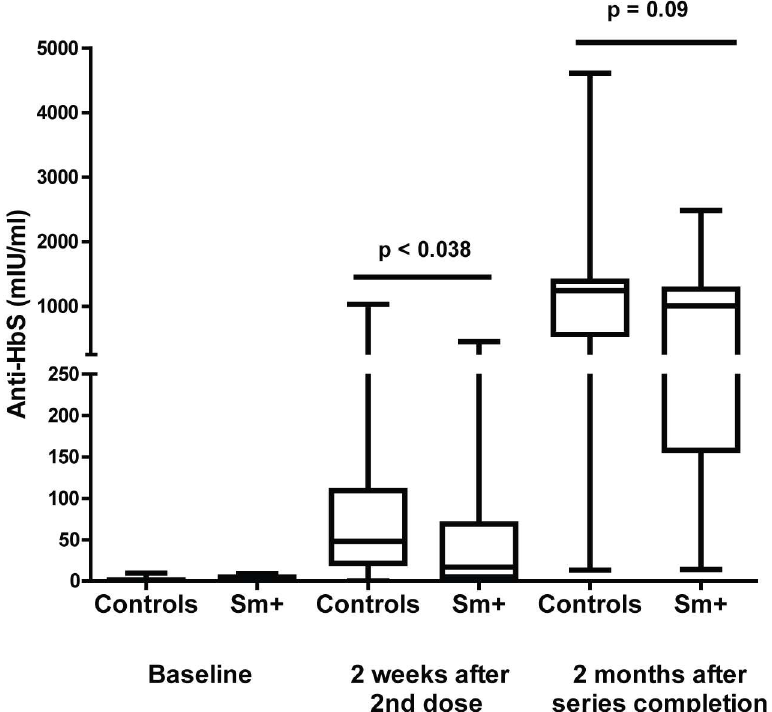
Fig 2. Schistosomiasis infection at the time of hepatitis B vaccination results in reduced antibody titers to hepatitis B surface antigen. Anti-HbSlevels were measuredby ELISA before vaccination,2 weeks after 2 nd vaccine dose, and 2 months after vaccine series completionwith individualswith schistosomiasis being treated for their infection1 week following2 nd dose of hepatitisB vaccine. Box plots show the median, lower 25 th percentile,and upper 75 th percentileanti-HbSlevels at each time point. Statistical differences at each time point were determined using the Mann-Whitney test with a p < 0.05 consideredstatistically